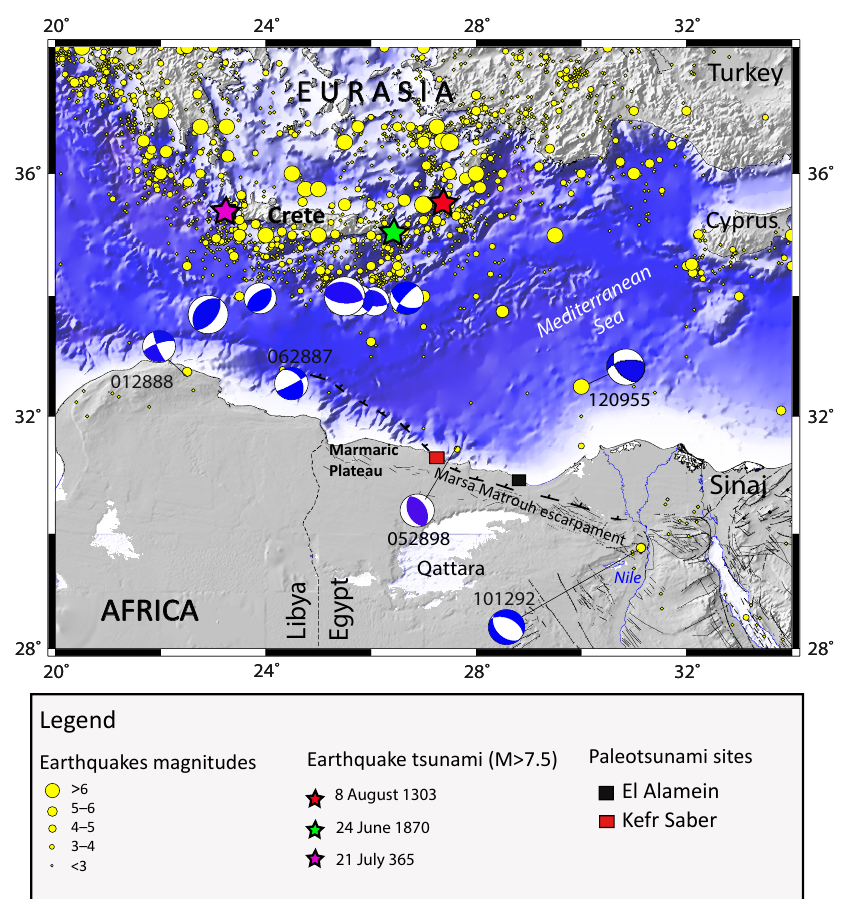
Figure 1. Seismicity (instrumental with M > 5.5) and main tectonic faulting (black lines) in northern Egypt. Boxes indicate the paleoseis- mic sites of Kefr Saber and El Alamein east of the Nile delta. The major historical earthquakes (star) of AD365 ( M w 8–8.5), AD1303 ( M w ∼ 8) and AD1870 ( M w > 7–7.5) are located along the Hellenic subduction zone according to Guidoboni et al. (1994), Stiros (2001), Ambraseys (2009), Papadopoulos et al. (2014) and Jusseret and Sintubin (2017). Focal mechanisms are from CMT-Harvard (referenced as CMT